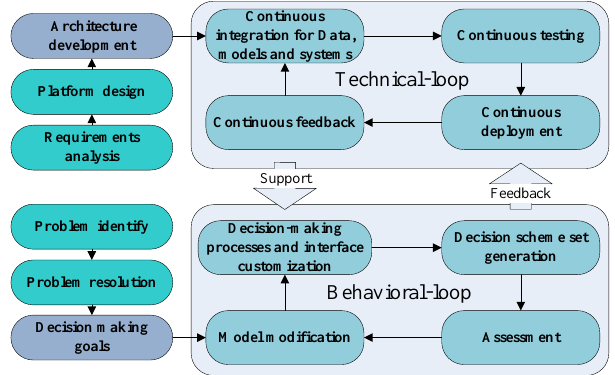
Fig. 2. Systems life cycle for model-driven methodological frame-